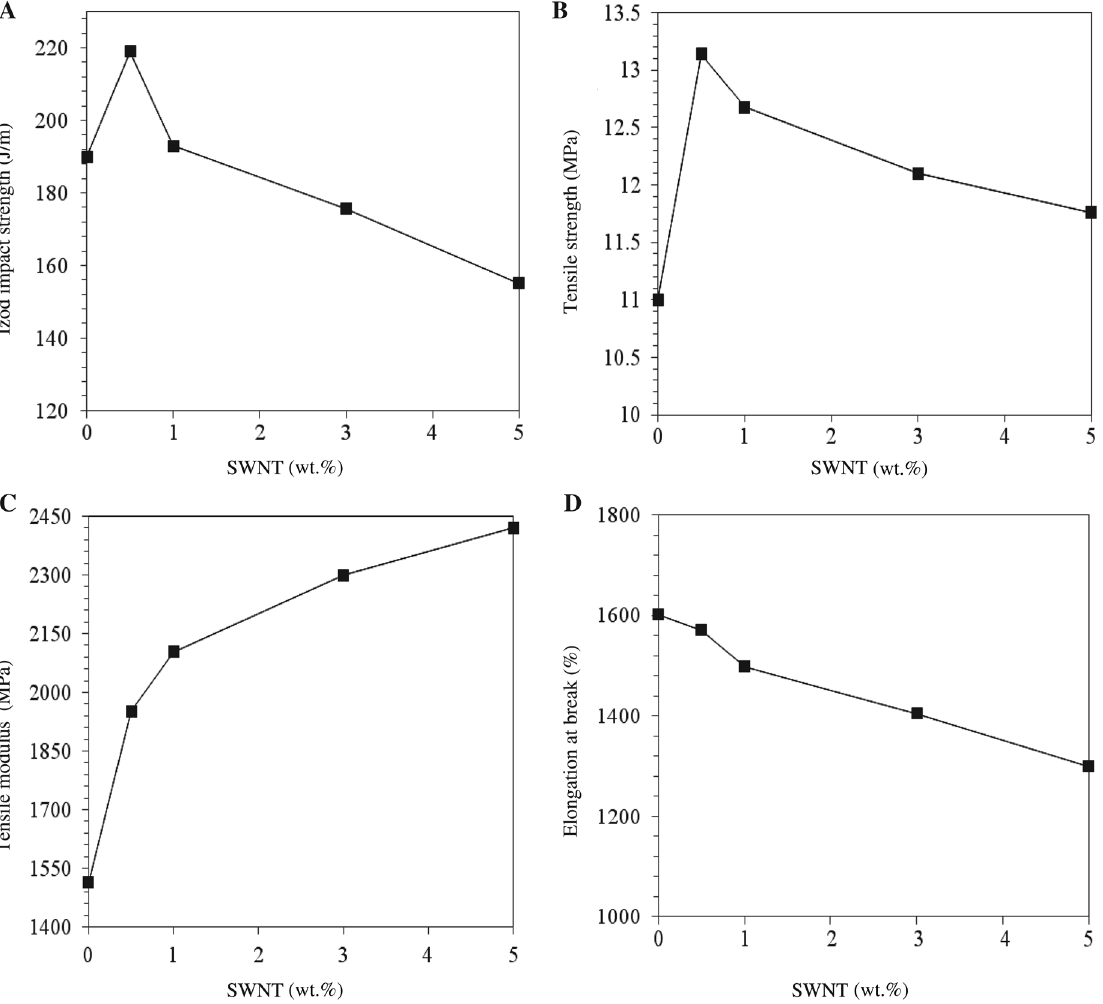
Figure 5 Mechanical properties of PP/EPDM/SWNT nanocomposites: (A) Izod impact strength, (B) tensile strength, (C) tensile modulus, (D) elongation at